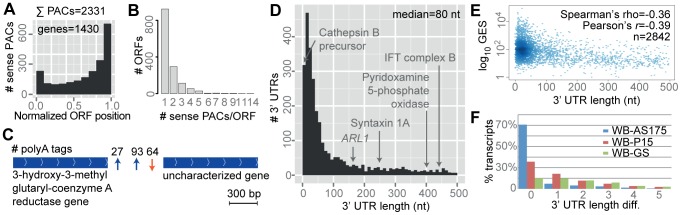
Polyadenylation sites.(A) Histogram of clustered polyadenylation sites (PACs) and their normalized position on ORFs. On the x-axis, 0 and 1 refer to the first and last base of the ORF. Only polyadenylation sites of the sense direction with respect to the ORF are shown. The y-axis shows the frequency. The data are from the WB isolate. (B) Bar-plot of the number of sense PACs per ORF. (C) Example of alternative polyadenylation of the gene encoding 3-hydroxy-3-methylglutaryl-coenzyme A reductase (GL50803_7573). Arrows indicate locations of the polyA site. Blue arrows indicate polyA sites of the same direction as the genes, and the orange arrow indicates a polyA site of the reversed strand. Numbers of supporting reads (polyA tags) are shown on top of the arrows. The polyA sites are separated by 275 bp. (D) Histogram of 3′ UTR length (nt) inferred from mapped polyA sites. Only the WB isolate is shown. (E) Relationship between gene expression signal (GES; log10 FPKM) and 3′ UTR length. The y-axis shows the log10 GES and x-axis shows the 3′ UTR length (nt). Only 3′ UTRs <500 nt are plotted. (F) Nucleotide length differences between orthologous 3′ untranslated regions.